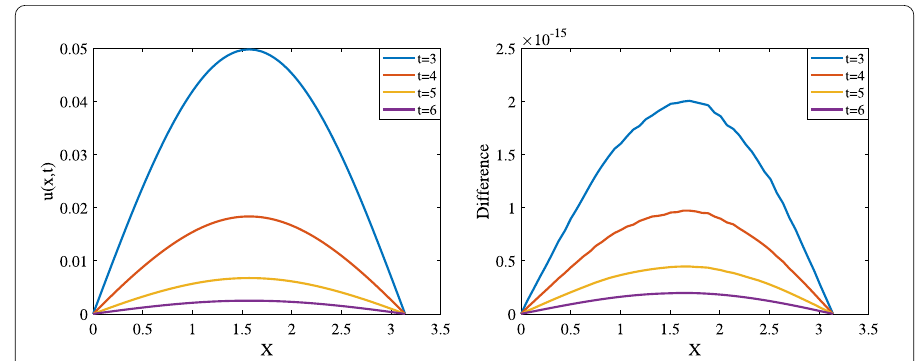
Figure 3 The figures of solutions of R-CFDS4(left) and difference(right) between R-CFDS4 and CFDS4 with h = 0.02 π , τ = 0.01 for SP 1